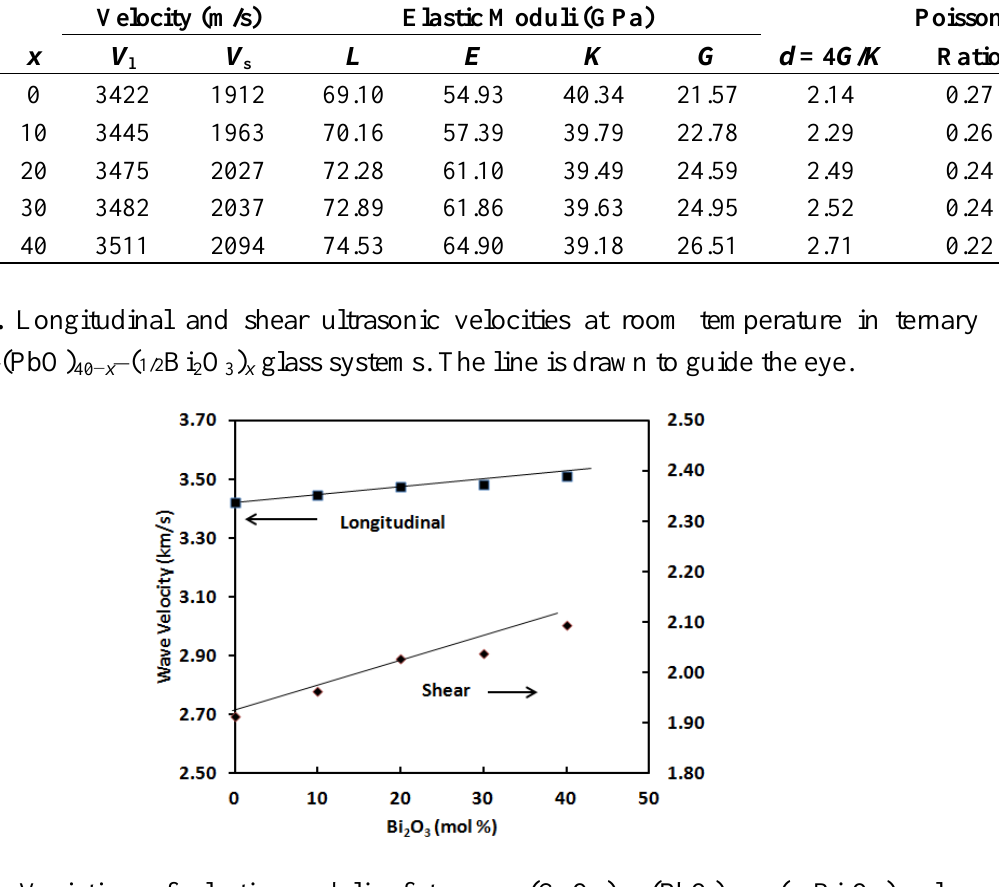
) –(PbO) –( 1/2 Bi O ) glass 2 60 40− x 2 3 x